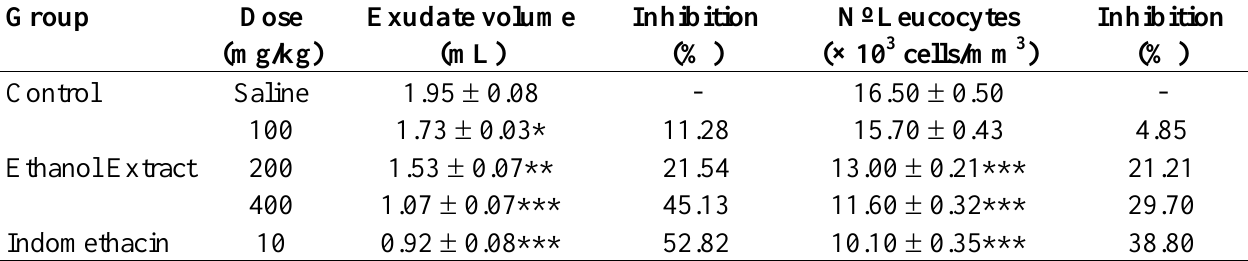
Table 3. Effects of the ethanol extract from M. platyclada leaves on pleural exudation and number of leucocytes in carrageenan-induced pleurisy in